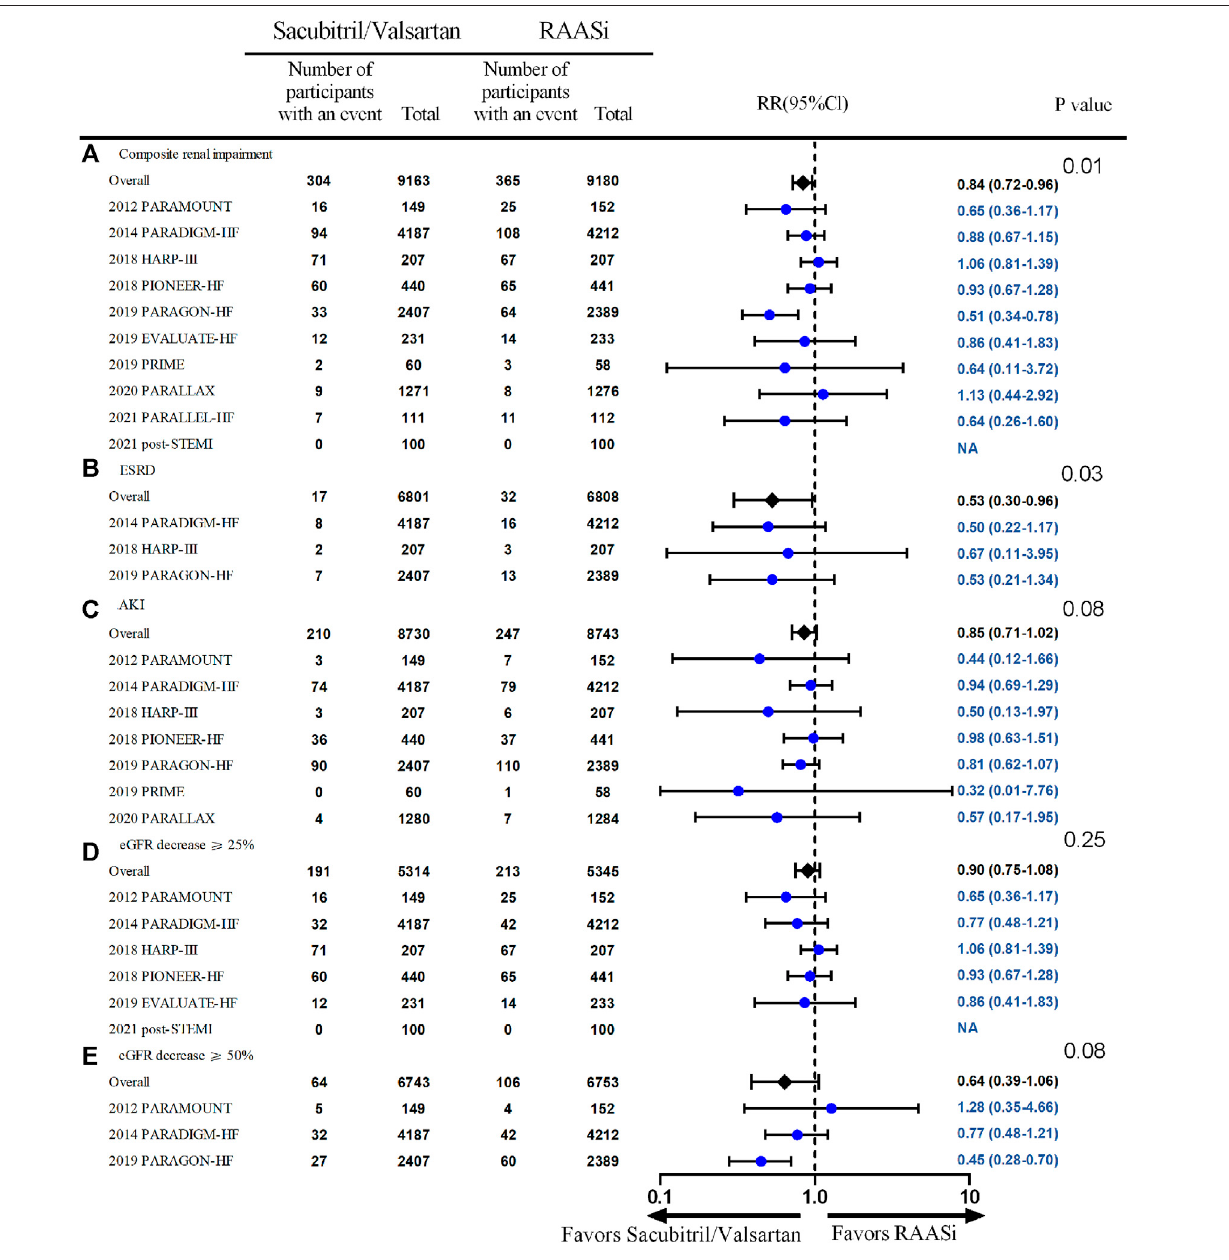
FIGURE 2 | Effect of sacubitril/valsartan on renal outcome — the outcomes of composite renal outcome, ESRD, AKI, eGFR decrease ≥ 25%, and eGFR decrease ≥ 50% are presented as (A,B,C,D,E) respectively. Outcomes, above except eGFR decrease ≥ 50% (E) , were from fi xed-effect meta-analysis. RAASi, renin – angiotensin – aldosterone system inhibitor; RR, relative ratio; AKI, acute kidney injury; ESRD, end-stage renal disease; eGFR, estimated glomerular fi ltration rate.